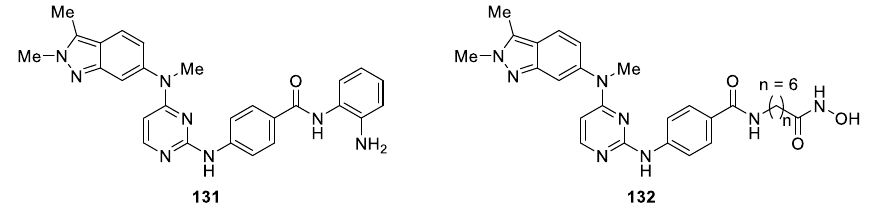
Figure 33. Chemical structures of 2 H -indazole derivatives 131 and 132.